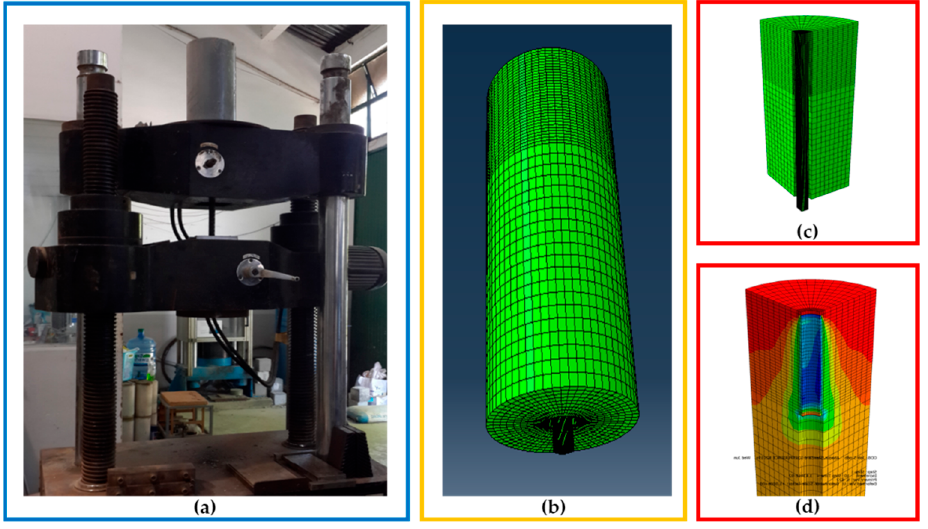
Figure 3. Concrete and reinforcing bar model in ABAQUS: ( a ) pull-out specimen; ( b ) pull-out modelling; ( c ) quarter of specimen; ( d ) stress distribution in concrete.